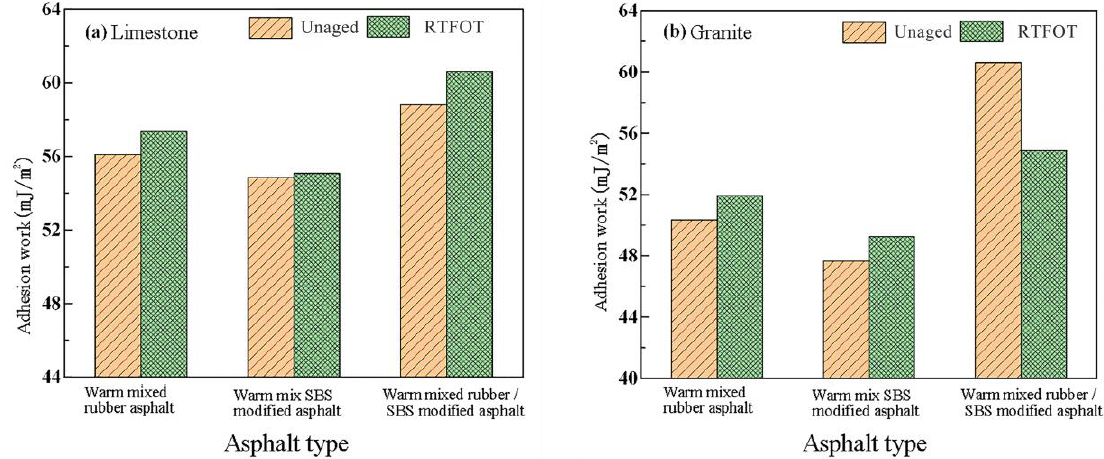
Figure 5. Adhesion work of asphalt and different aggregates before and after aging: ( a ) Limestone and ( b ) Granite.